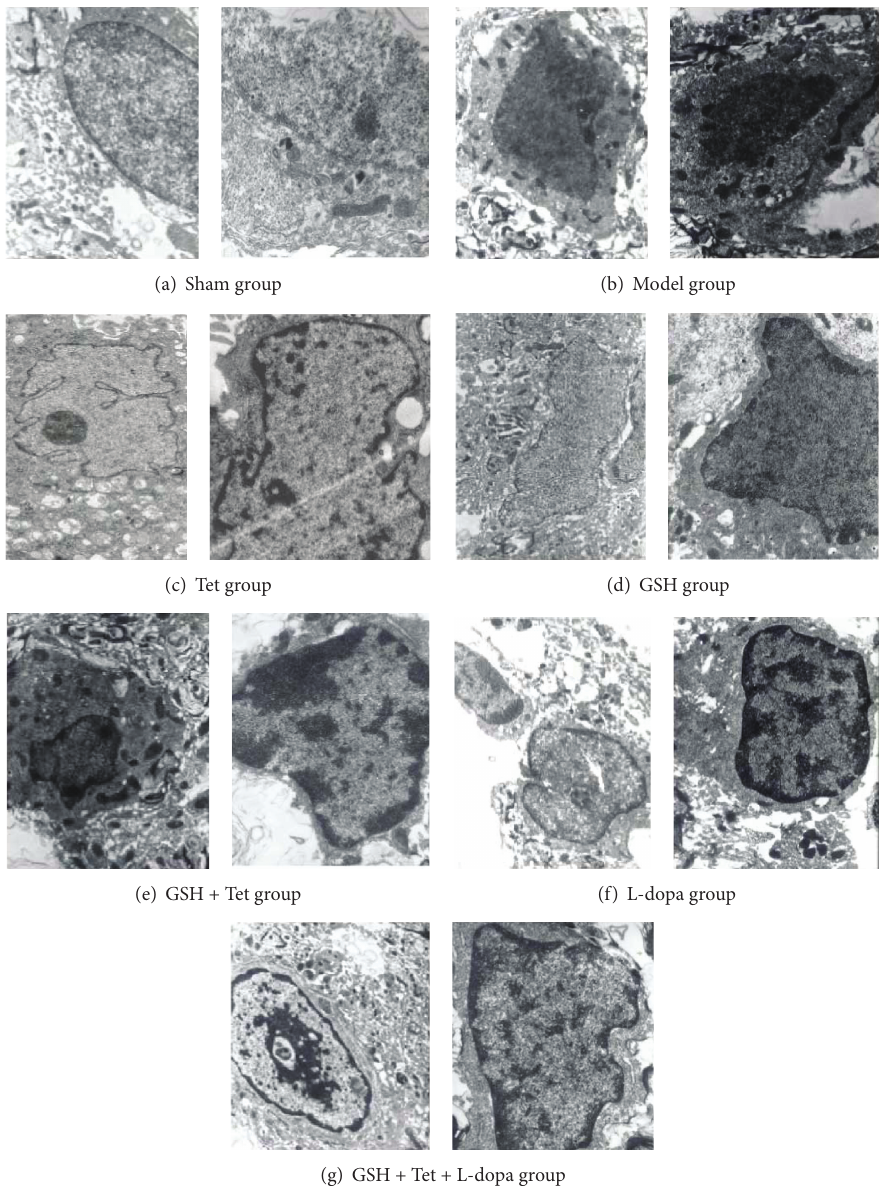
Figure 6: Transmission electron microscopy (TEM) images of apoptotic dopaminergic neuron in the substantia nigra pars compacta (SNc) of lesion sides. Images for all groups were taken using the same magnification (in one group, the left at 11,000x, the right at 15,000x). Dopaminergic neurons with normal cellular morphology were detected in the sham group. The model group showed characteristics of apoptosis in the early PD stage. The L-dopa group, however, displayed characteristics of apoptosis in the middle-late PD stage. In the Tet group and GSH groups, changes of apoptosis were less obvious compared with the L-dopa group. In the GSH + Tet and GSH + Tet + L-dopa group, several dopaminergic neurons were in preapoptosis